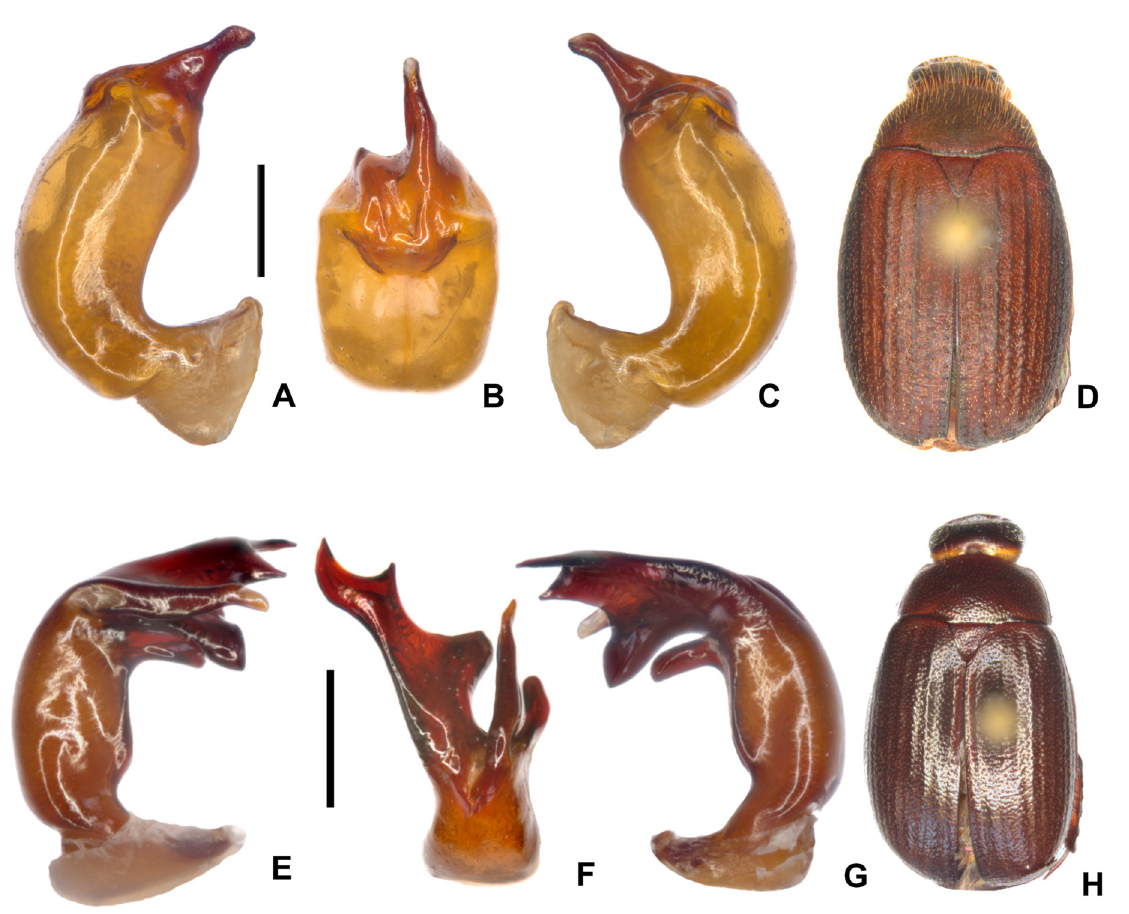
Fig. 4. A–D . Maladera galdaththana sp. nov. (holotype). E–H . M. cervicornis sp. nov. (holotype). A, E . Aedeagus, left side lateral view. C, G . Aedeagus, right side lateral view. B, F . Parameres, dorsal view. D, H . Habitus (not to scale). Scales: 0.5